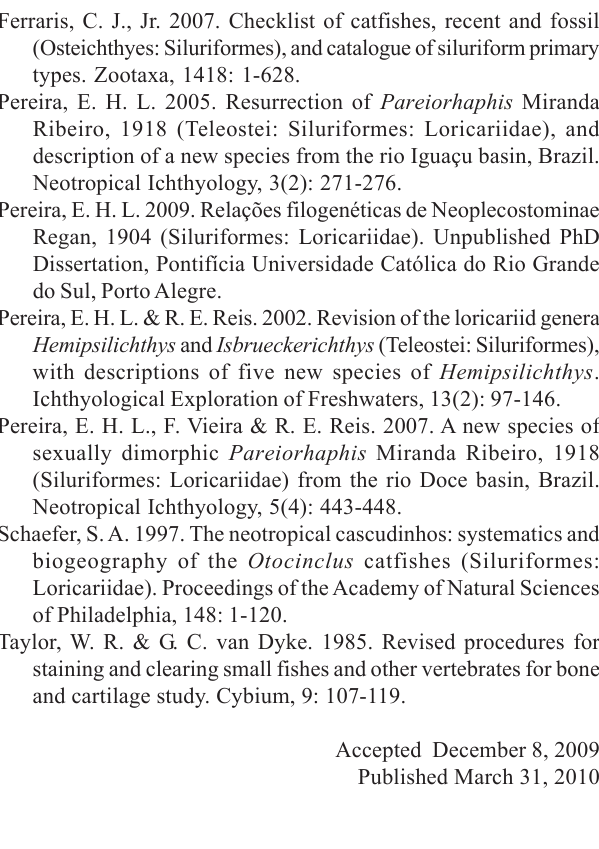
Fig. 5. Suspensory bones of Pareiorhaphis . (a) P . parmula , MCP 35827 and (b) P . scutula , MCP 37182. HYO - quadrate. Right side, lateral view. Scale bar = 5 mm.